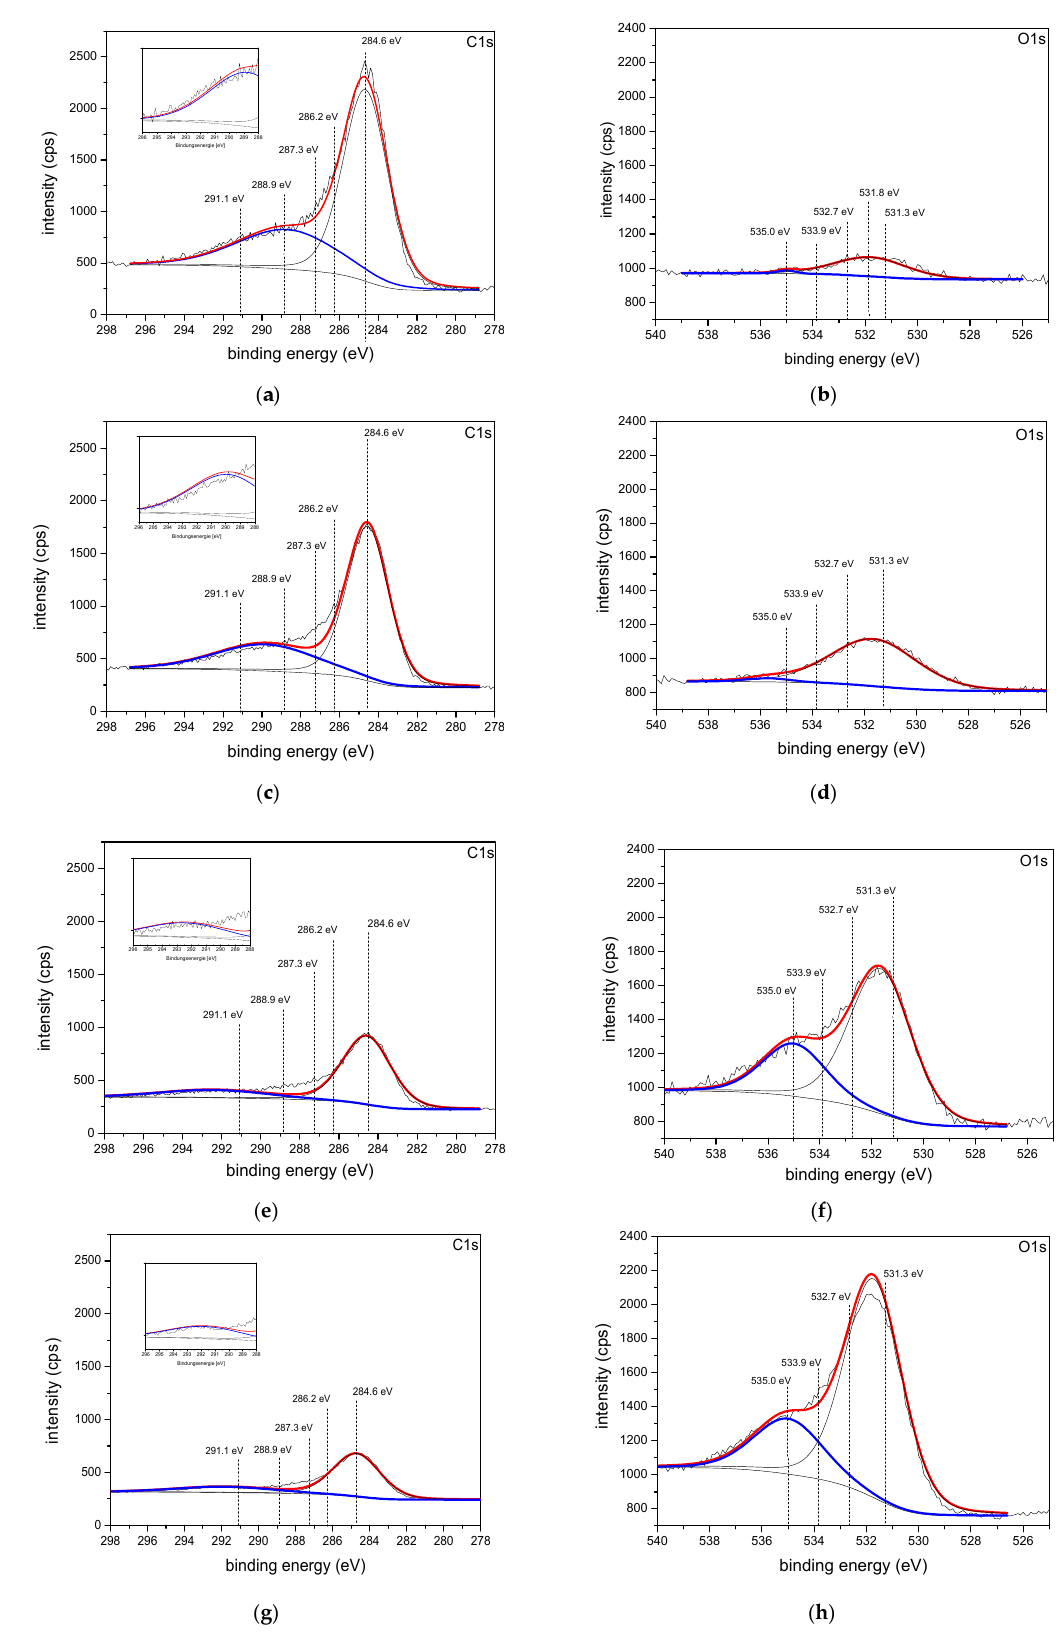
Figure 12. XPS analyses of carbon (C1s) and oxygen (O1s) areas of CNTs, ( a ) + ( b ) pristine CNTs, ( c ) + ( d ) oxidized according to “Ox 2”, ( e ) + ( f ) oxidized according to “Ox 2_3” and ( g ) + ( h ) oxidized according to “Ox 2_5”.